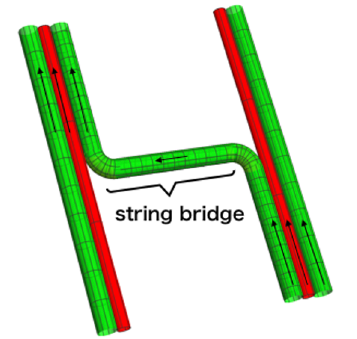
Figure 3 . A schematic picture of the string system after the collision. The red rod is a (cid:30) 1 -string with n 1 = 1. The green rod is a (cid:30) 2 -string with n 2 = 1. The arrows on the strings denote the magnetic (cid:13)ux in the strings. We call the string segment connecting two strings the string bridge. The string bridge is formed by the reconnection of the bunch of the strings. The strings are cut for drawing